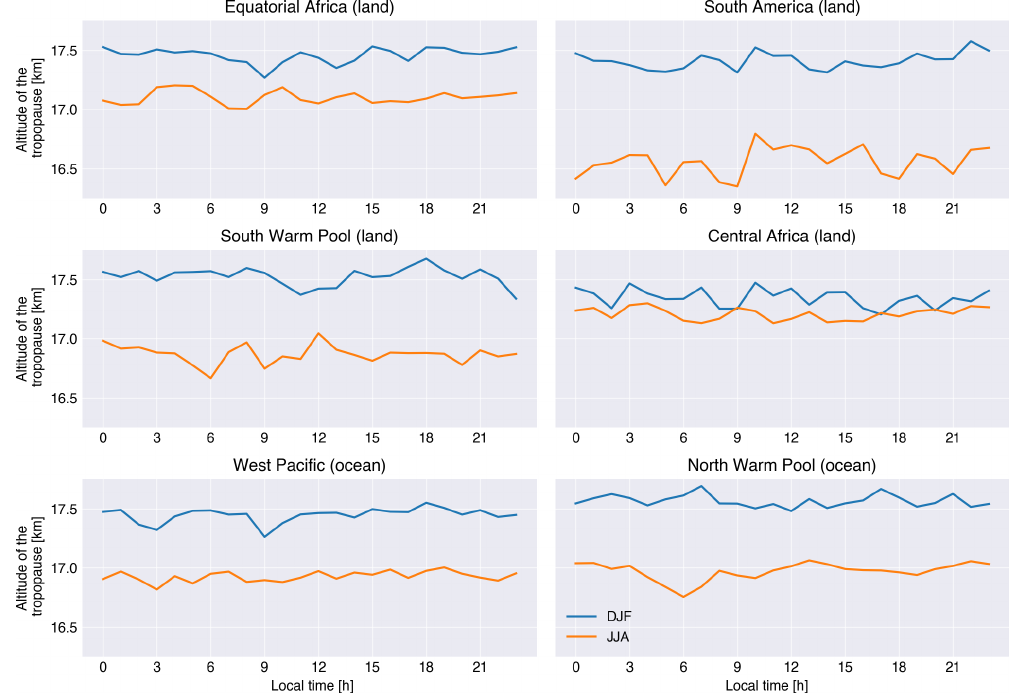
Figure A1. Diurnal cycle of the tropopause altitude over each considered tropical region (DJF in blue and JJA in orange).